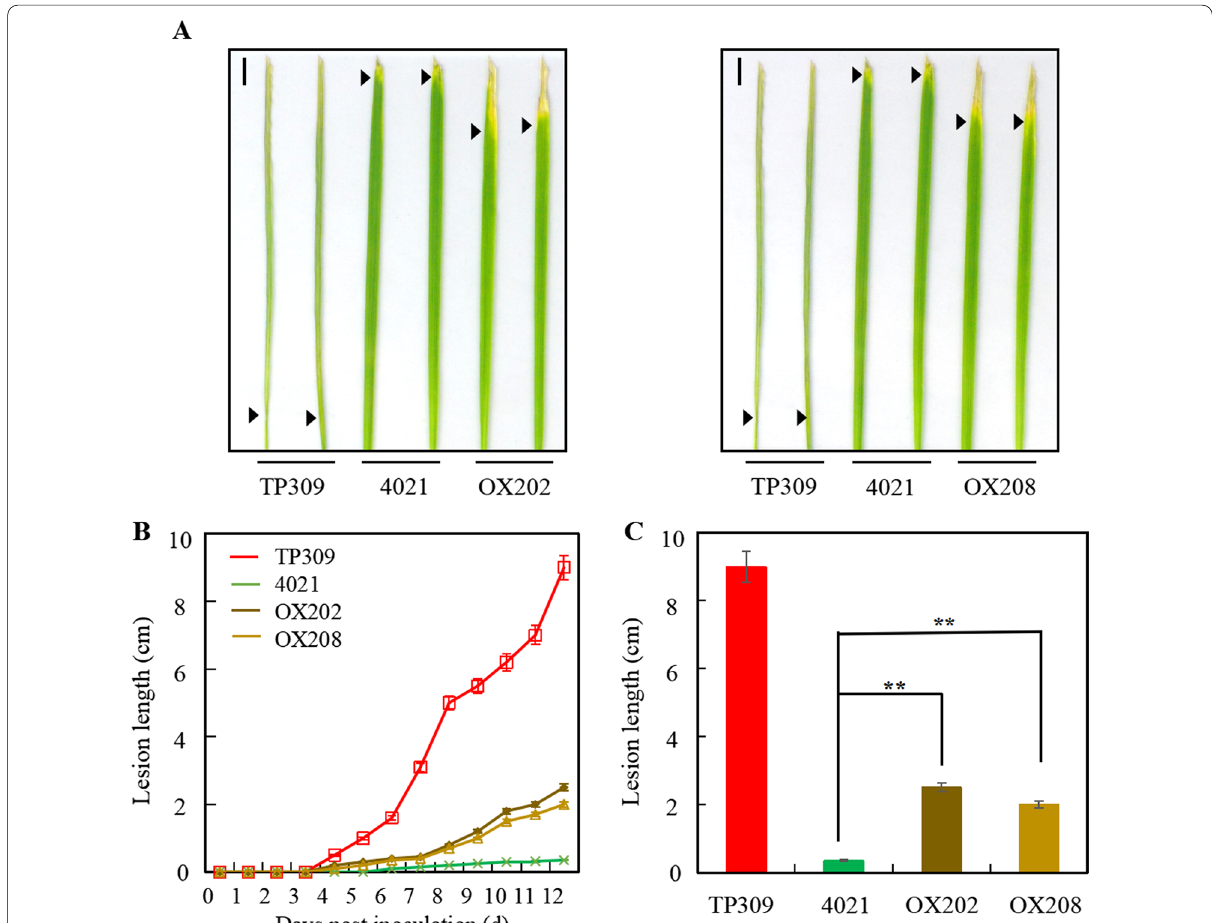
Fig. 7 Xa21 -mediated resistance in rice following overexpression of MPK17 at 27 °C. A Lesions in inoculated leaves of OX202, OX208 and control plants at 12 dpi. B Lesion length at different dpi. C Lesion length at 12 dpi. Arrows indicate the frontline of lesions. **designate difference at p < 0.01 level. Bar 1 cm. OX202 and OX208: independent MPK17-OX transgenic lines; TP309: Japonica rice variety; 4021: TP309 transgenic line harboring = the Xa21